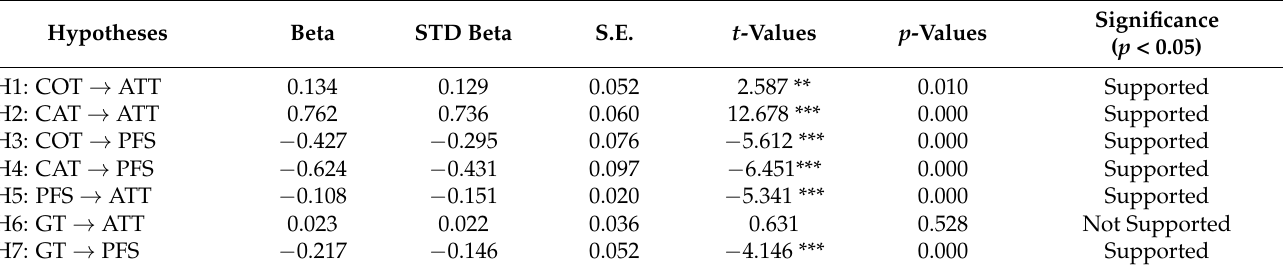
Table 5. Structural Equation Model and Hypothesis Testing